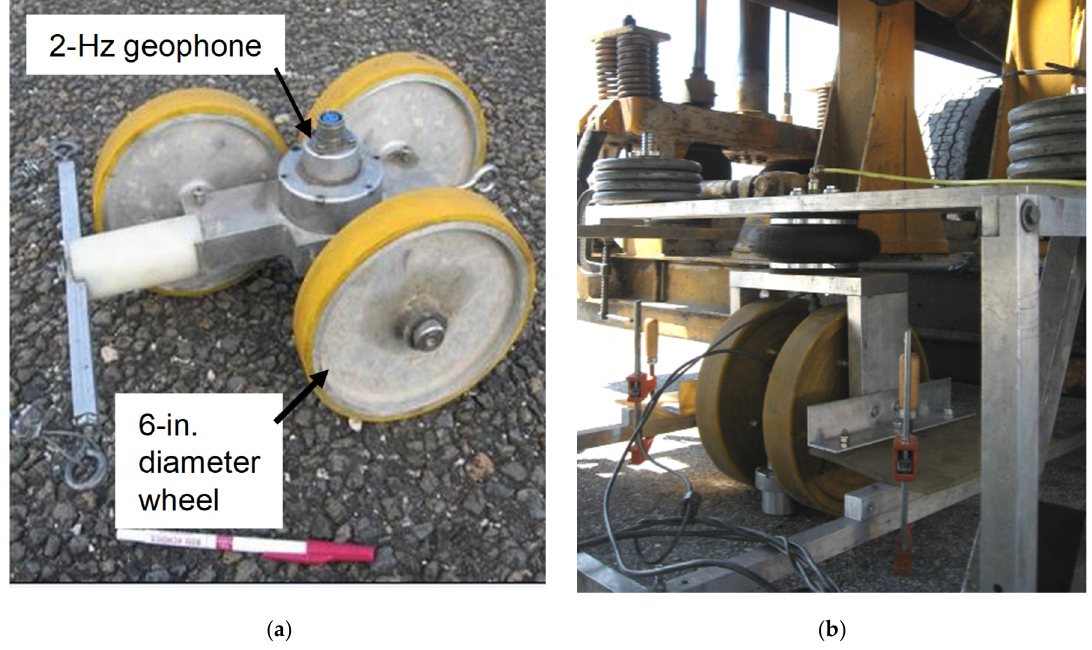
Figure 2. The rolling sensors of the RDD: ( a ) Old rolling sensor, and ( b ) new rolling sensor.